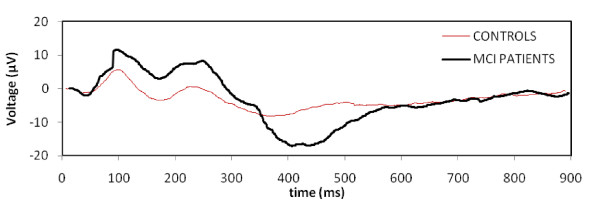
Grand average AERP waveforms for MCI patients (n = 91) and controls (n = 30).